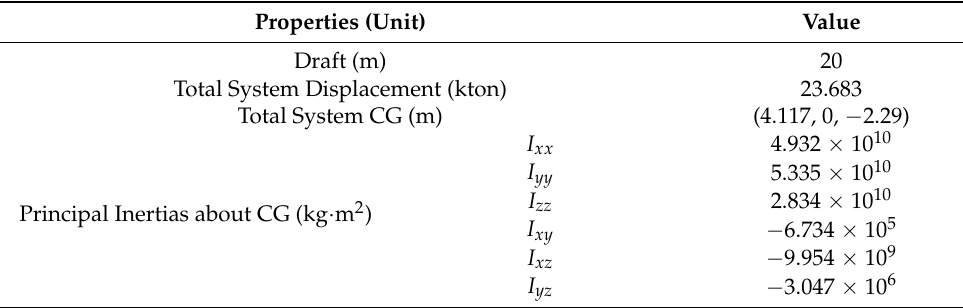
Table 1. Specifications of Taida